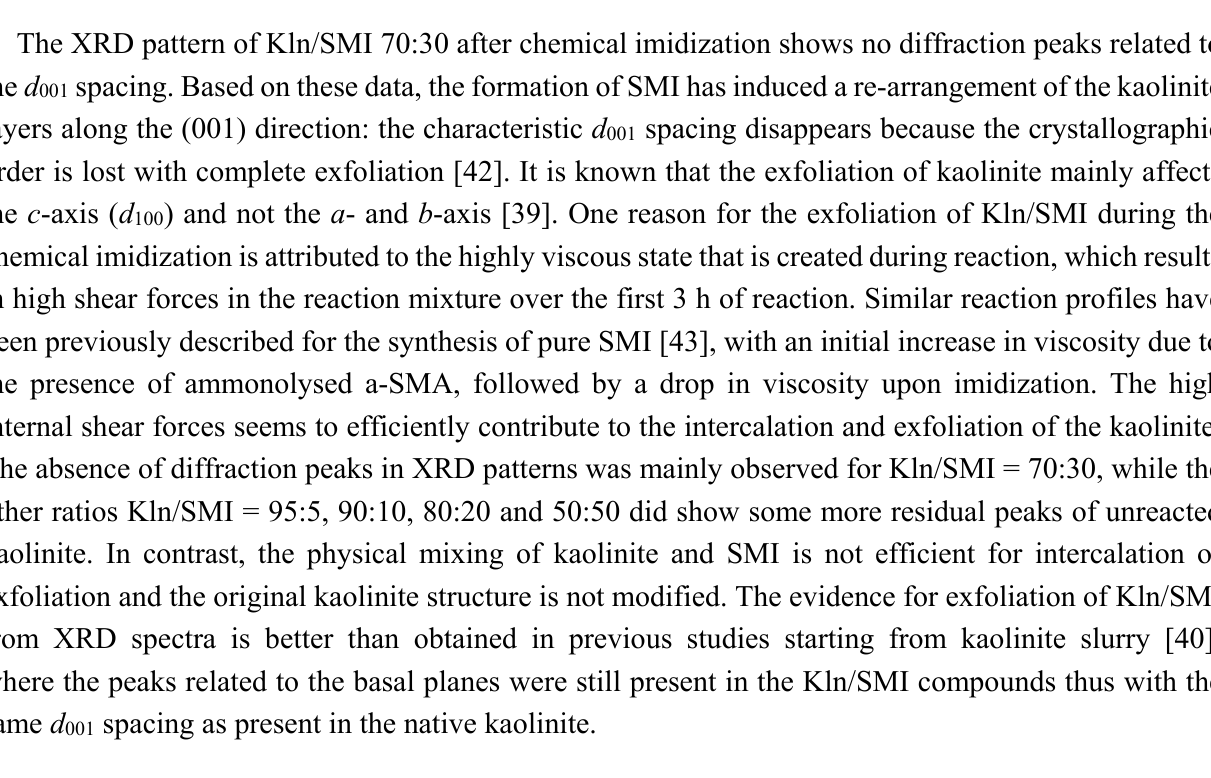
Table 1. Summary of the intercalation properties for Kln/a-SMA including intercalation ratio (I.R.), interlayer distance d 100 and interlayer distance variation ( d